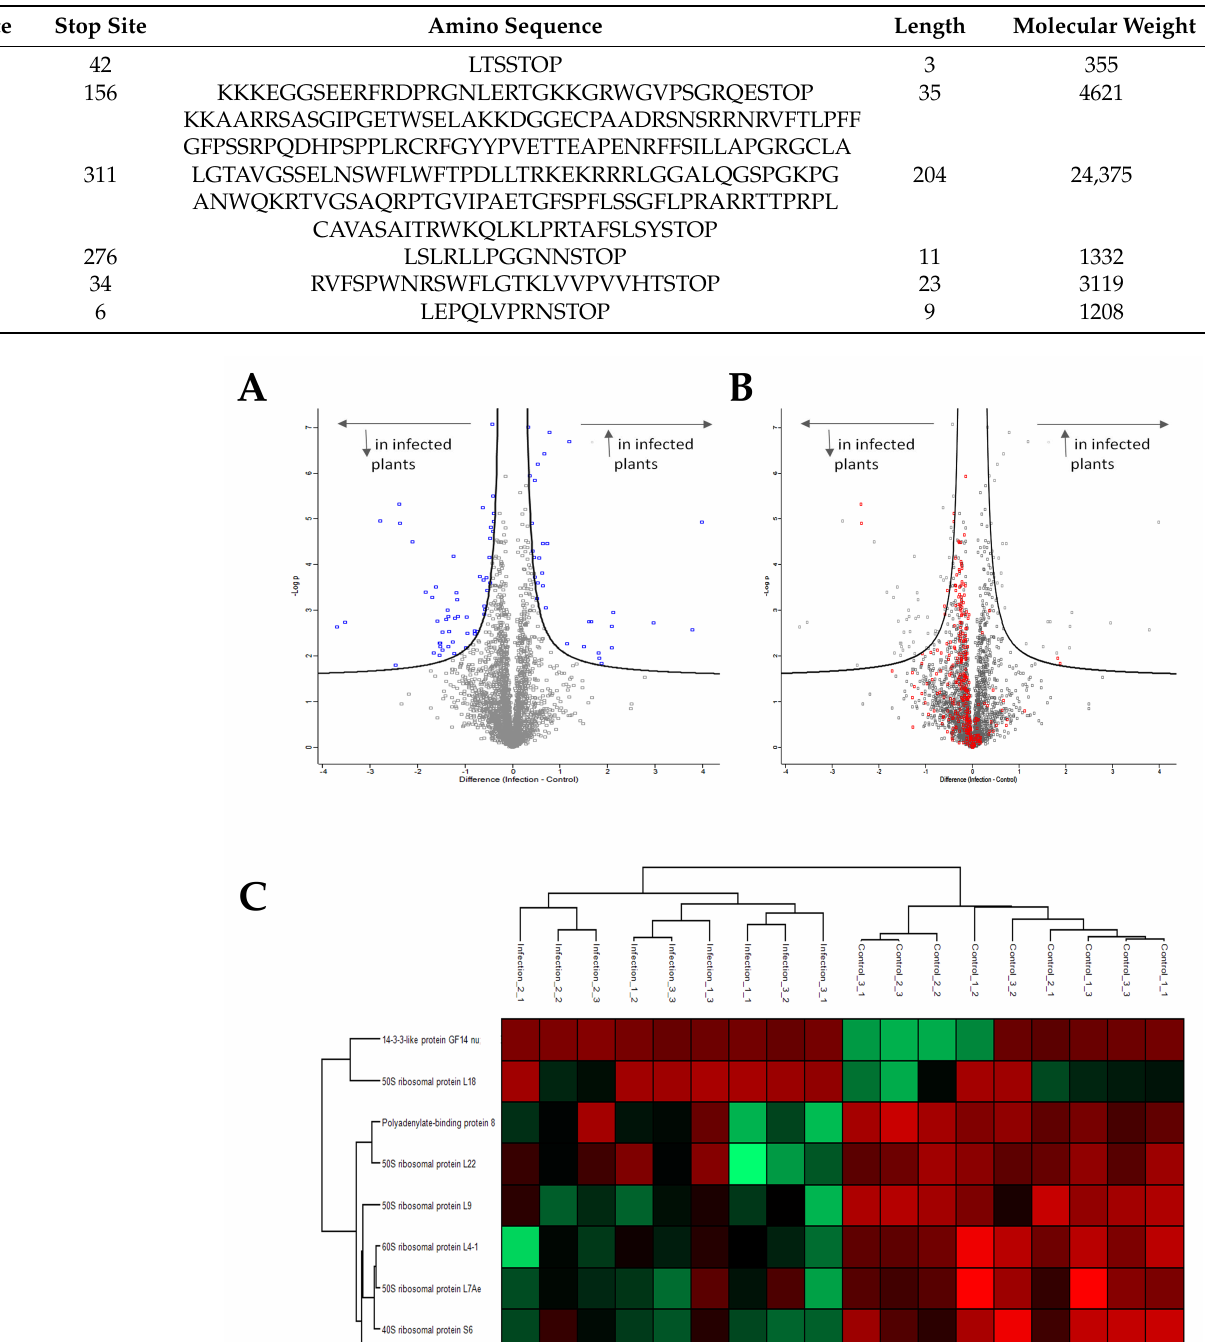
Table 3. Predicted Peptides for PSTVd NB .